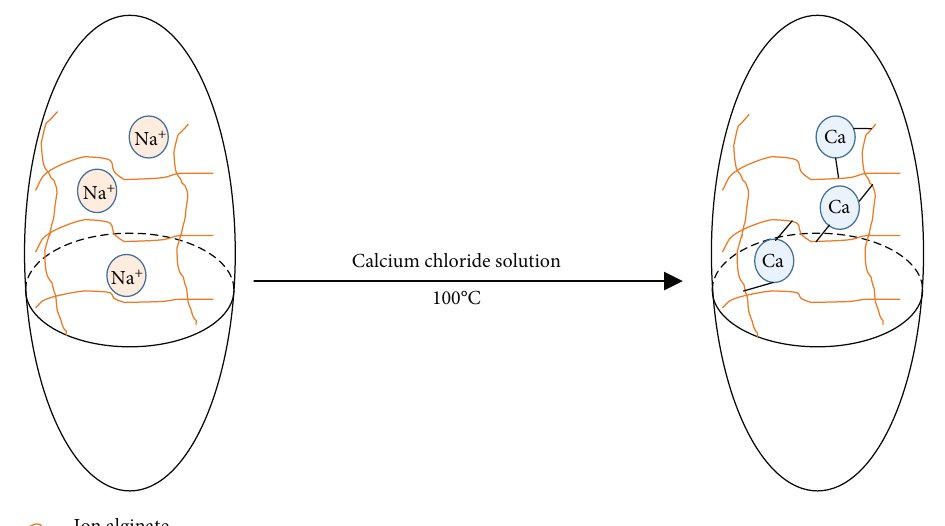
Figure 6: Complex e ff ect of sodium alginate and calcium chloride on rice